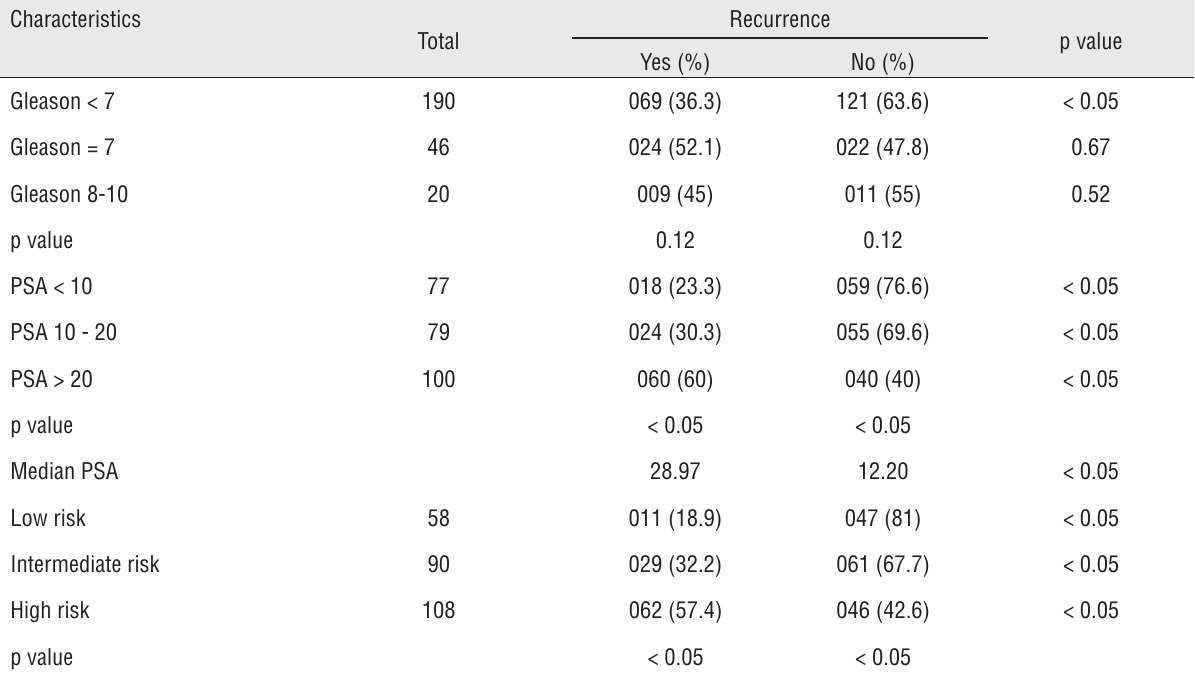
Table 6 - Biochemical recurrence after